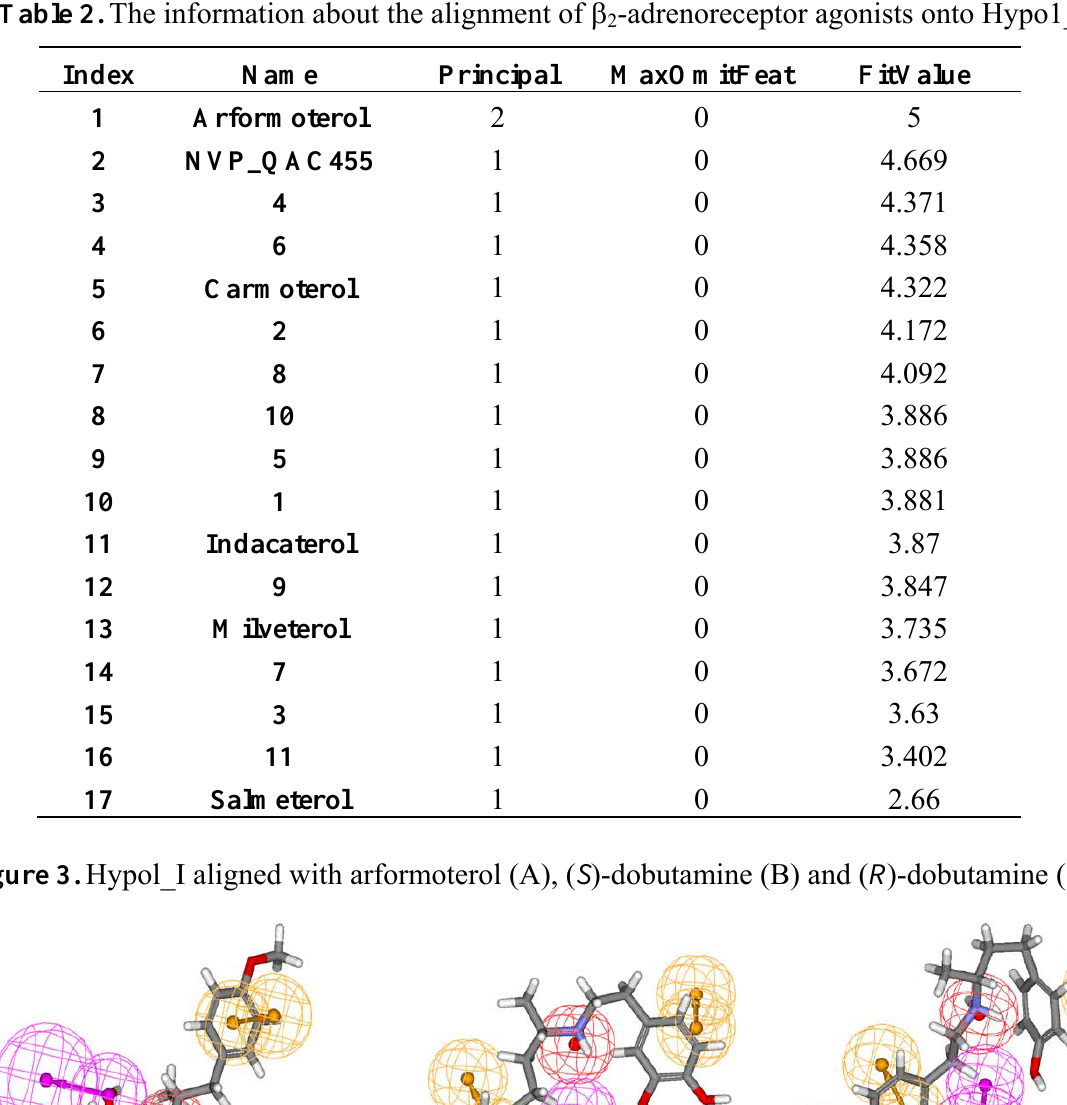
Table 2. The information about the alignment of β